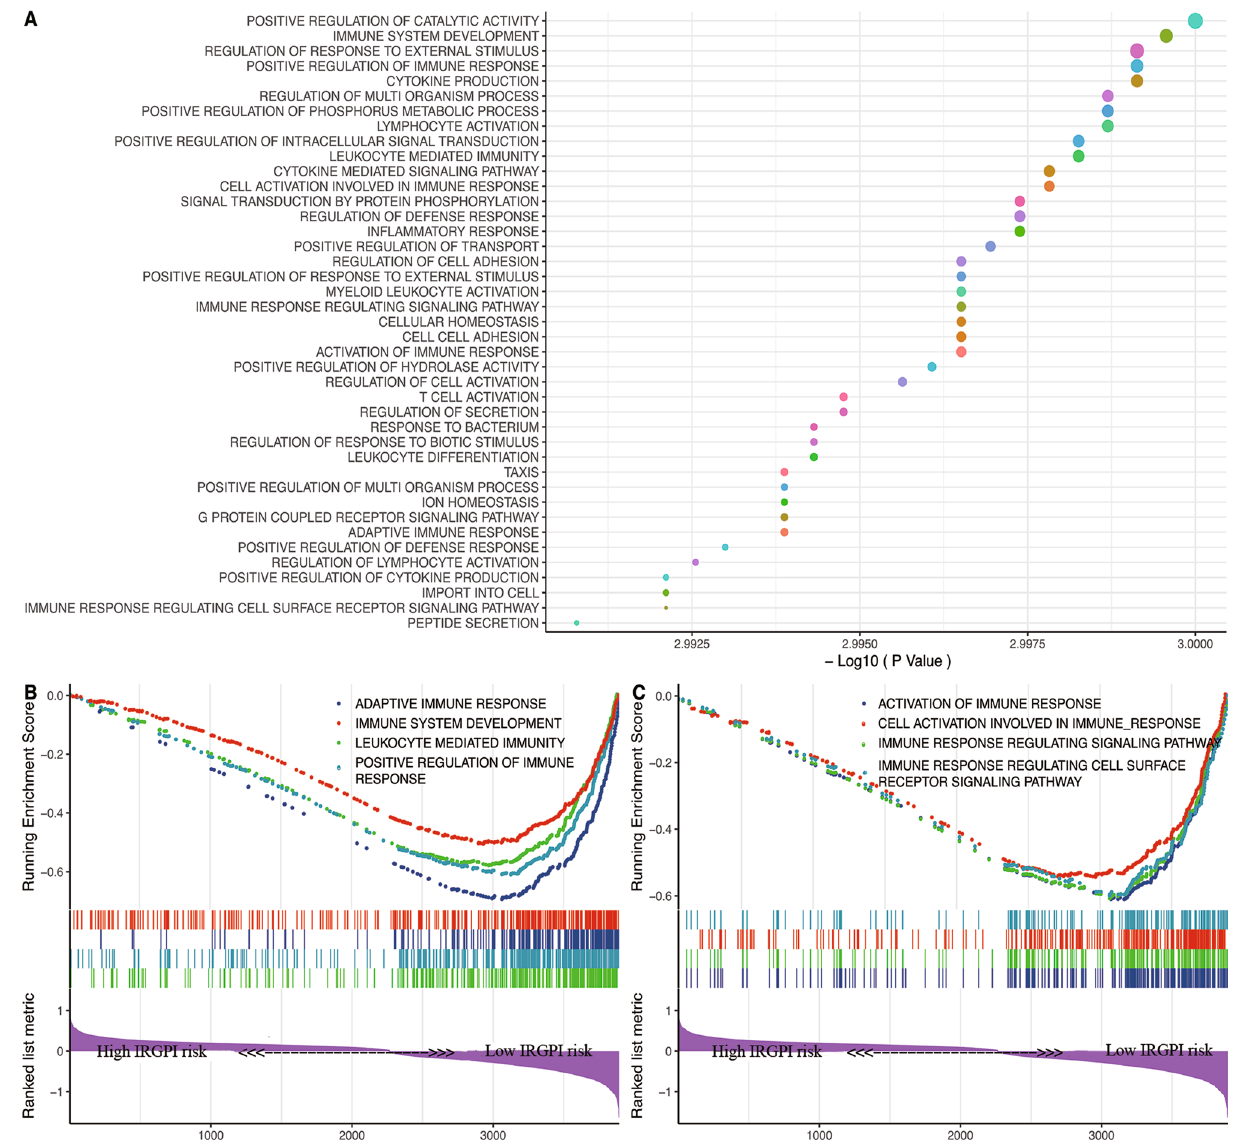
Figure 6. Parts of Gene Set Enrichment Analysis (GSEA) results, including adaptive immune response; immune system development; leukocyte mediated immunity; positive regulation of immune response; activation of immune response; cell activation involved in immune response; immune response regulating signaling pathway; immune response regulating cell surface receptor signaling